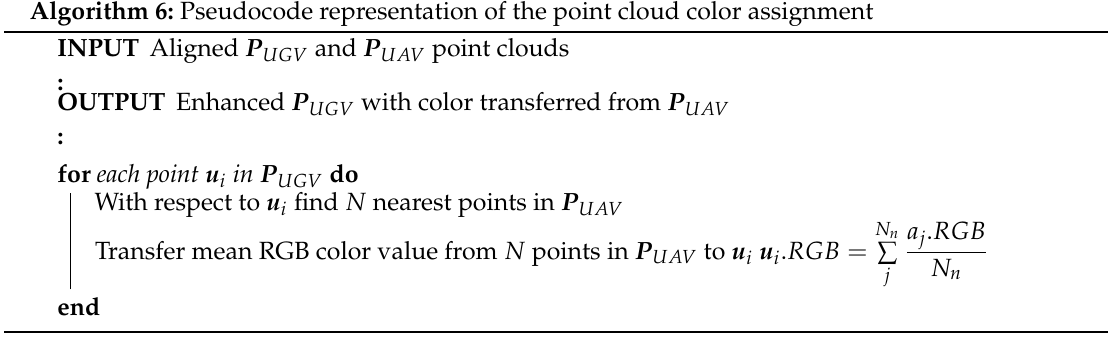
Algorithm 6: Pseudocode representation of the point cloud color